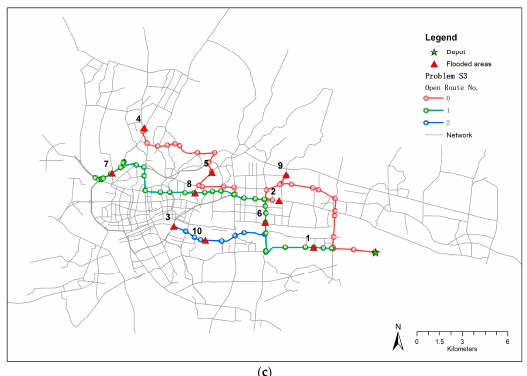
Figure 8. Rescue routing plans of problems S1, S2, and S3. ( a ) The rescue routing plans of S1; ( b ) The rescue routing plans of S2; ( c ) The rescue routing plans of S3.